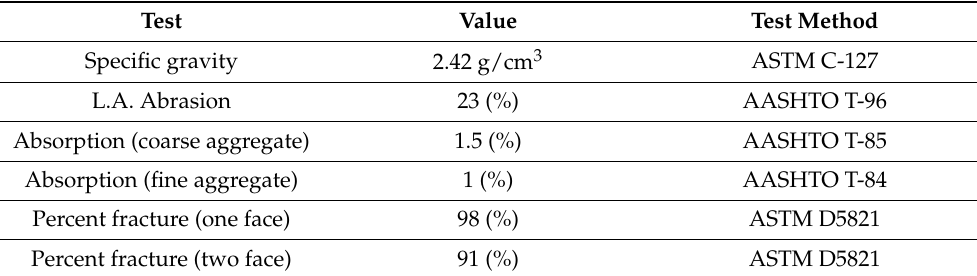
Table 1. Physical properties of aggregates used for manufacturing the HMA.